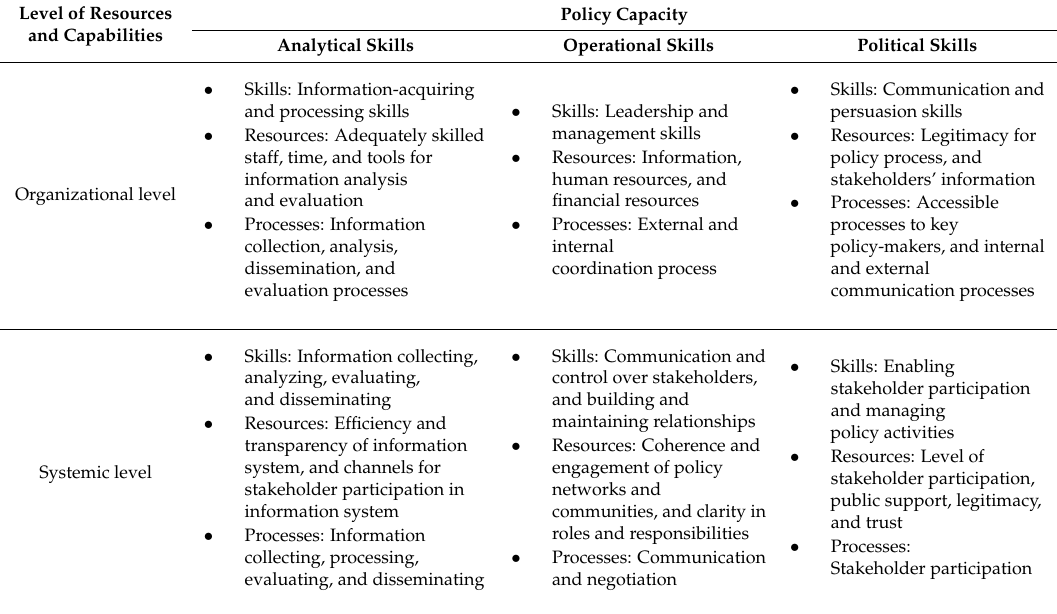
Table 5. Three elements of policy capacity under the modified analytical framework at the organizational and systemic